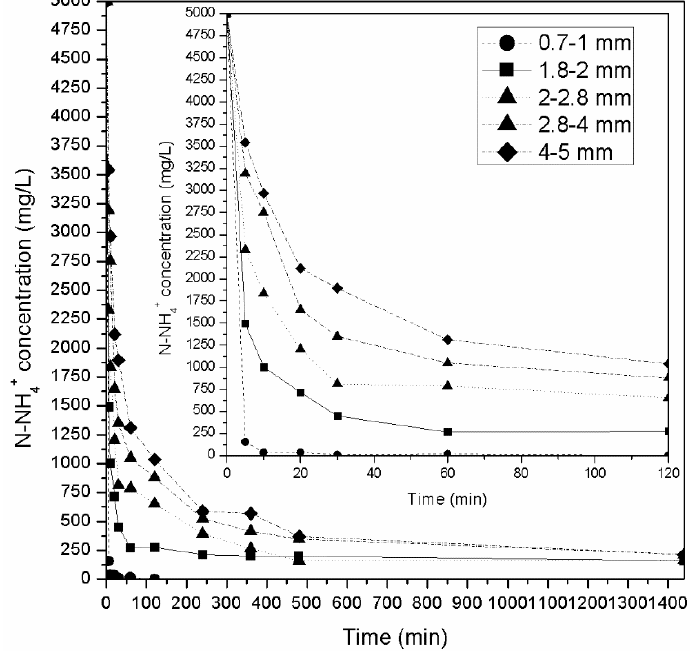
Figure 5. Effect of contact time on ammonium removal by natural zeolite of different-sized particles in column experiments with an initial NH 4+ -N concentration of 5000 mg/L. Table 5. Results of the column desorption experiments.